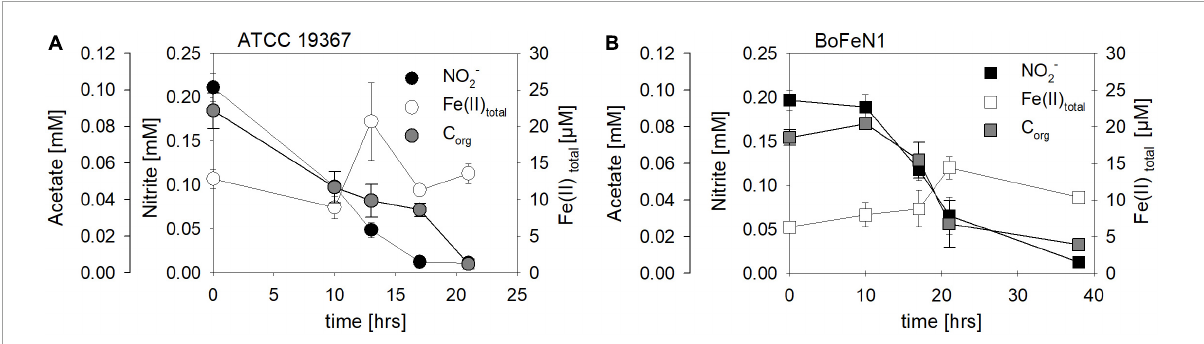
FIGURE6 Concentrations of NO 2 − ( (cid:108) , (cid:3) ), Fe(II) to tal ( ◦ , (cid:3) ) and acetate ( (cid:108) , (cid:3) ) over time in experiments testing NO 2 − reduction coupled to Fe(II) oxidation in Acidovorax sp. strain BoFeN1 (A) and Paracoccus denitrificans strain ATCC 19367 (B) . Note different time scales. Error bars represent standard error calculated from biological replicates [ n = 4 (A) , 3 (B) ].